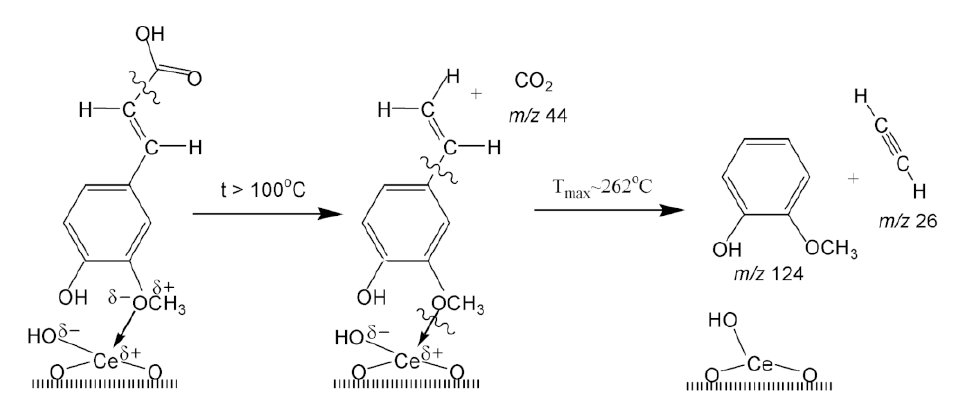
Scheme 6. The guaiacol